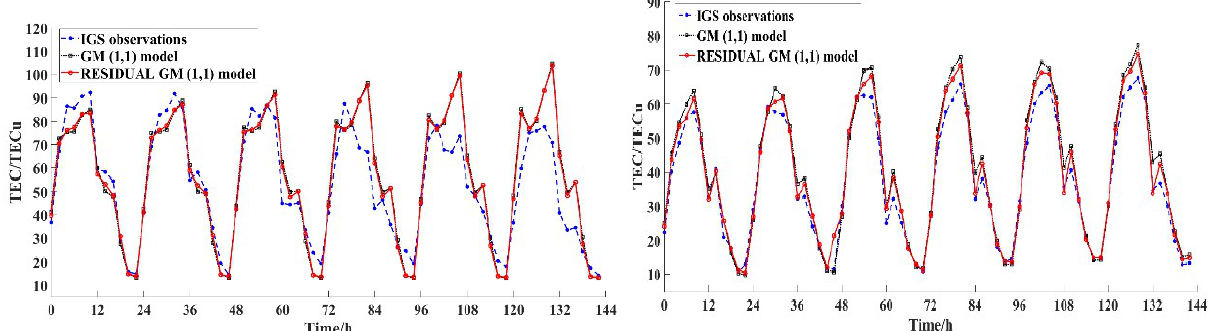
Figure 3. TEC forecast for 6 days in autumn at low latitudes